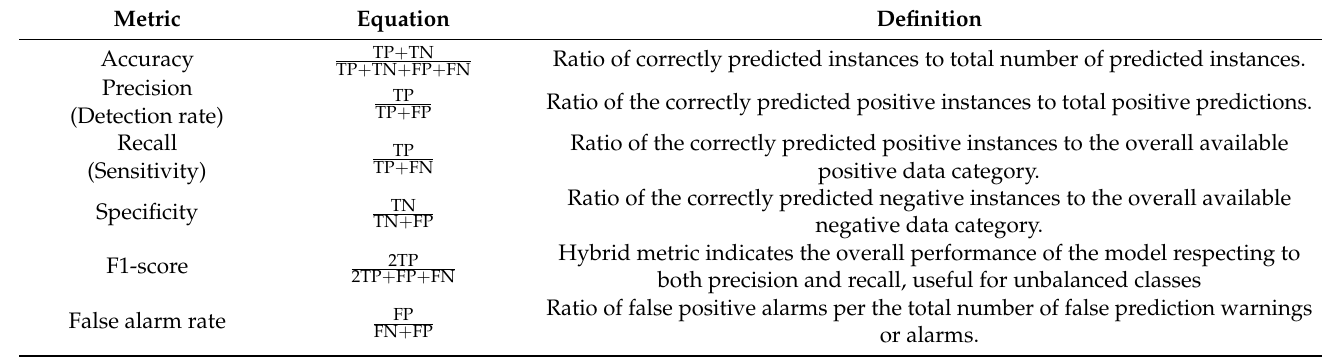
Table 3. Effectiveness main metrics.